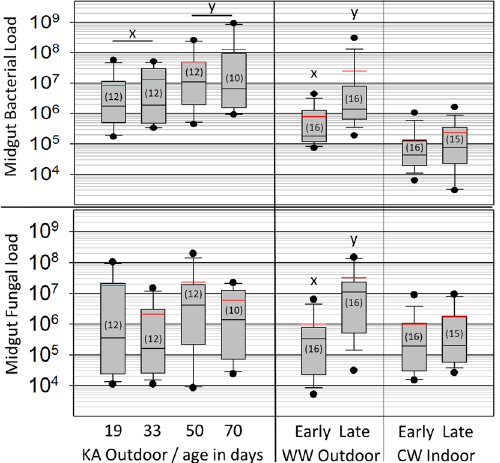
Figure 4. Bacterial and fungal load in the worker midgut of over wintering honey bees. The y-axis is log10 transformed and represents 16S rRNA copy number (bacterial load) and 18S rRNA copy number (fungal load). The WW samples differed significantly from early to late winter for both fungal load (W 32 = 42, p = 0.0008) and bacterial load (W30 = 43, p = 0.003). See “Methods” for more sampling details. Grey boxes contain 50% of the variation, whiskers contain 90%, and the dots represent the range. The horizontal red bar is the mean and black is the median. Bacterial load corresponds to microbiotas in Fig. 3 (KA) and Fig. 5 (WW/CW). Sample sizes in parentheses. Boxplots created with SigmaPlot (Systat Software, San Jose, CA).